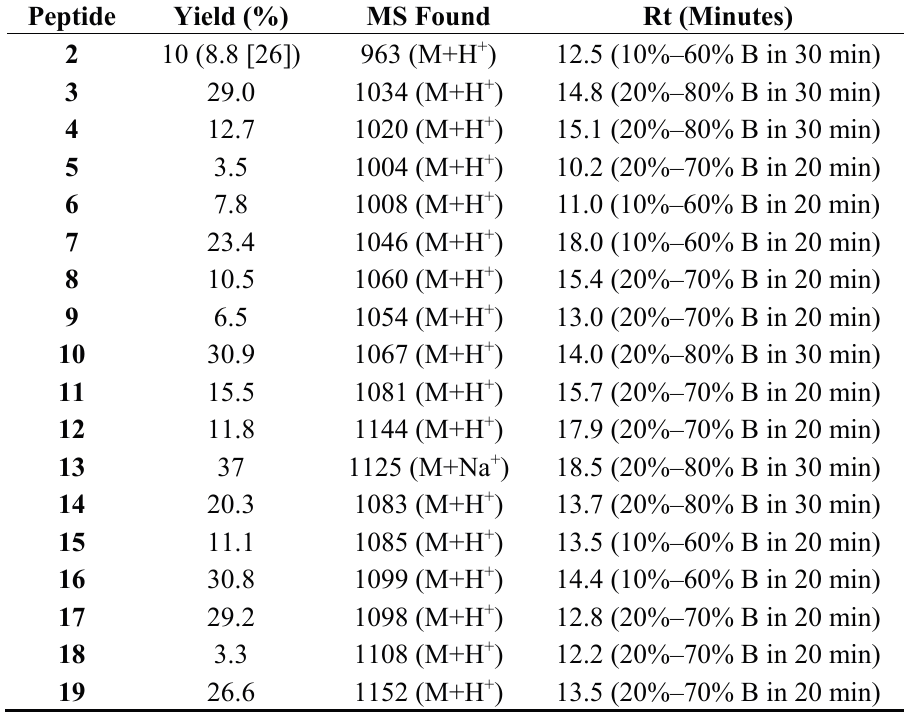
Table 3. Cyclic peptides with C-terminal modifications. Yield is the total yield of linear peptide synthesis and its cyclization. MS is obtained by ESI + method. HPLC retention times (Rt) obtained by the gradient indicated (mobile phases A: 0.1% TFA aqueous; B: